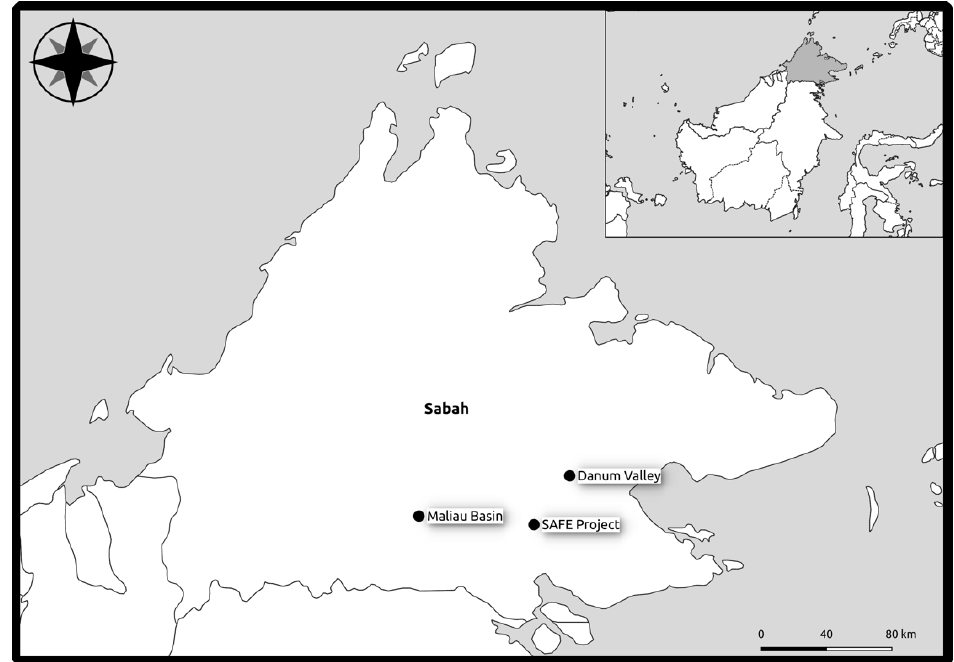
Figure 1. Map of study area and plot locations in Northeastern Borneo.